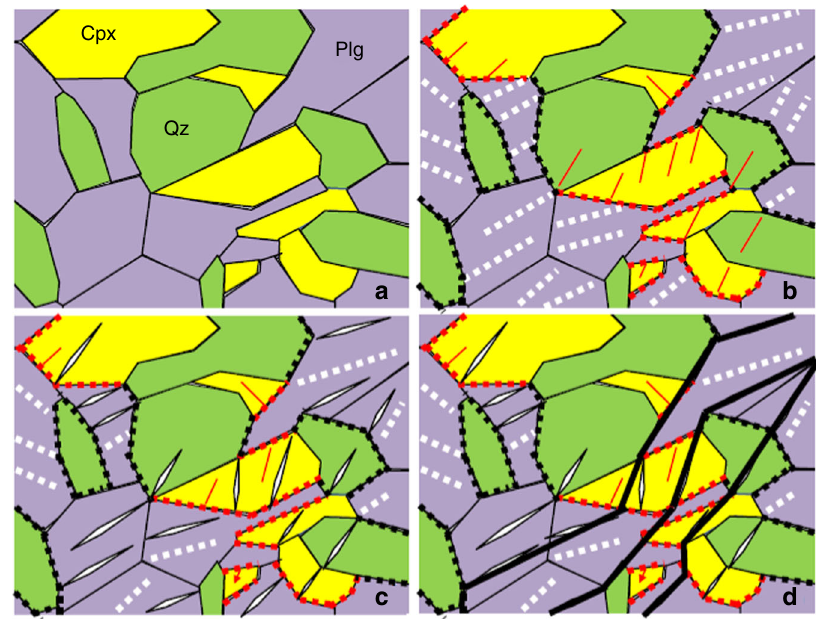
Fig. 9 Schematic illustration of the self-organization process of fault zones in metastable granulite deformed in eclogite stability fi eld. a Initial microstructure with clean grain boundaries and mineral separation among Plg, Cpx, and Qtz. b Reactions (1) and (2) occur along the Plg + Cpx (red dashed lines) and Plg + Qtz interfaces (black dashed lines). Within Plg grains Reaction (3) takes place (white dashed lines). These are the nuclei of NRBs. As reactions proceed, stress concentration sites increase along interfaces, initializing micro-cracks propagating inward individual grains (thin red lines). c NRBs grow within Plgs grains and along mineral interfaces, causing shear displacements in Plg grains and grain boundary sliding. Micro-cracks occur in Cpx